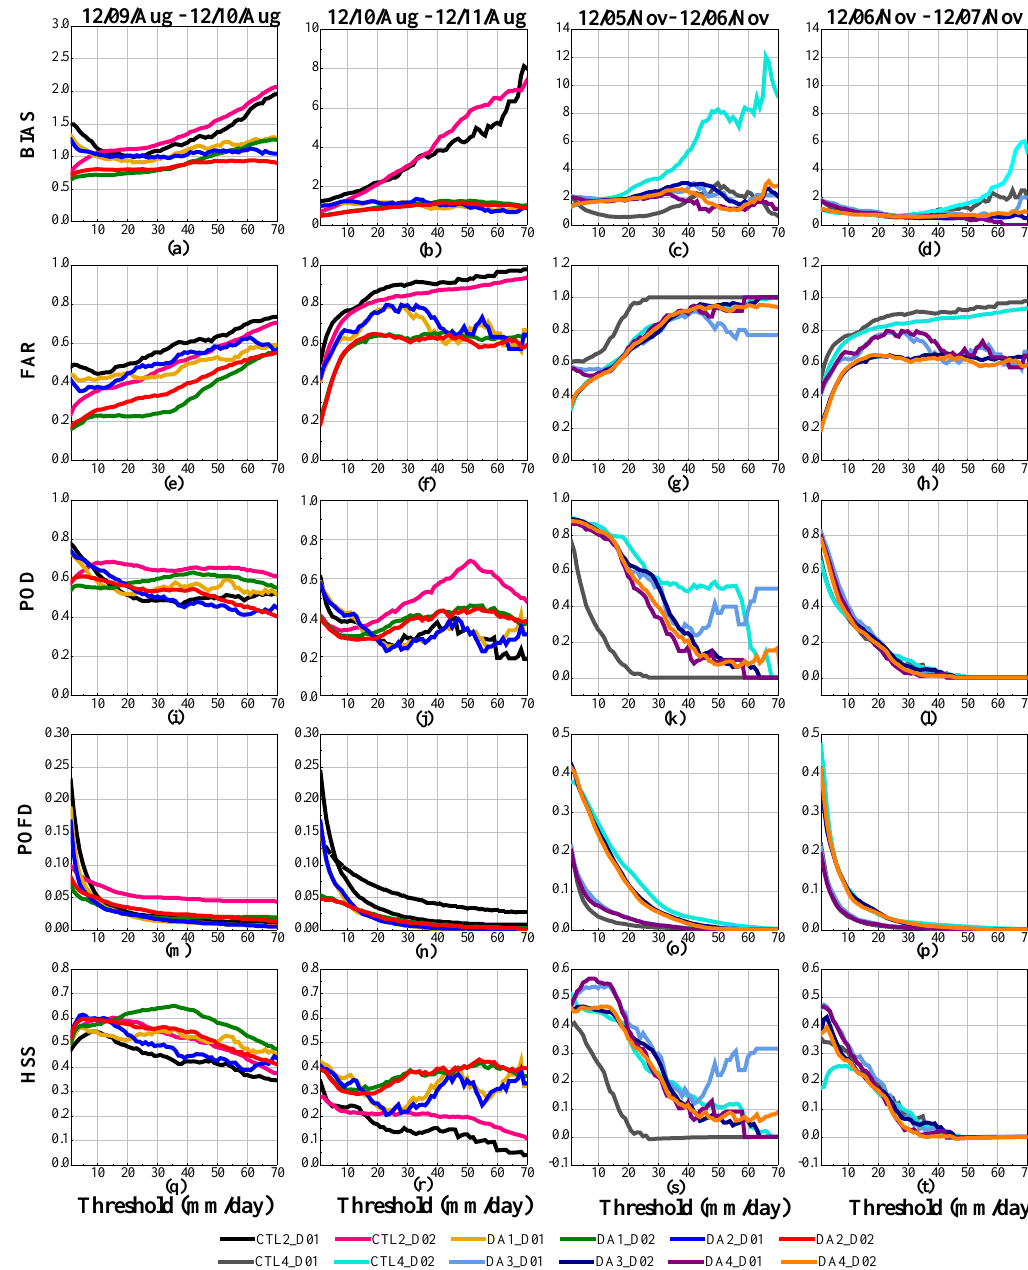
Figure 10. Skill scores of daily precipitation (mm/day) obtained from the CTL2, CTL4, and DA experiments in comparison with the merged CMORPH estimations at different thresholds ranging from 1 mm/day to 70 mm/day. ( a - d ), ( e - h ), ( i - l ), ( m - p ) and ( q - t ) are the skill scores of BIAS , FAR , POD , POFD and HSS , respectively, for the daily precipitation in the first and second days of the event A and the event N.